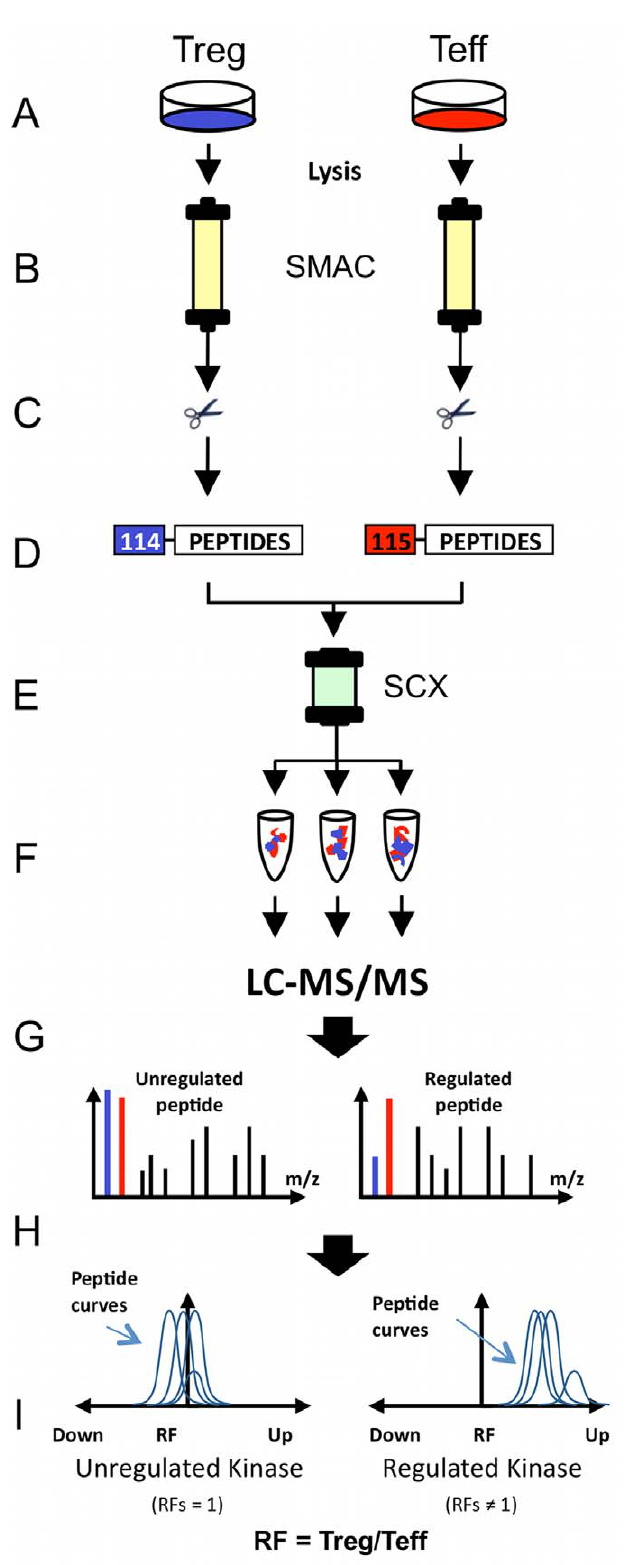
Figure 2. Experimental strategy for the comparative analysis of kinase-dependent signaling networks in Tregs and Teffs. ( A ) Ex vivo expansion of human T cell subsets. ( B ) Protein kinase purification by VI16743/Purvalanol-B-based small molecule affinity chromatography (SMAC). ( C ) Kinase elution, denaturation and tryptic digestion. ( D ) Quantitative peptide labeling with iTRAQ TM and sample combination. ( E ) Separation of complex peptide sample by Strong Cation Exchange Chromatography (SCX). ( F ) LC-MS/MS analysis of multi-dimensional separated peptide fractions.